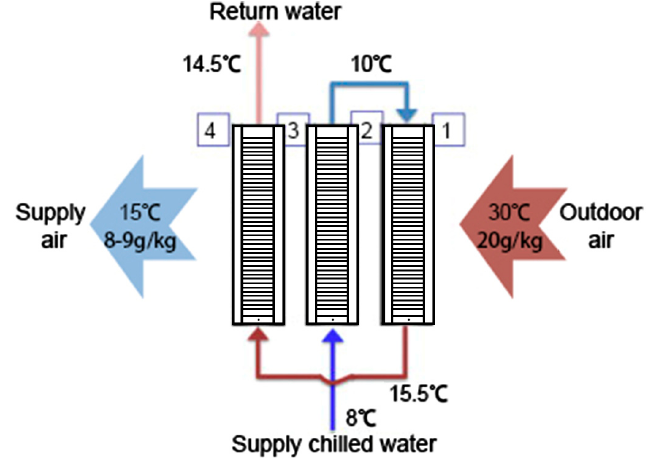
Figure 11. Arrangement of the three heat exchangers [44].